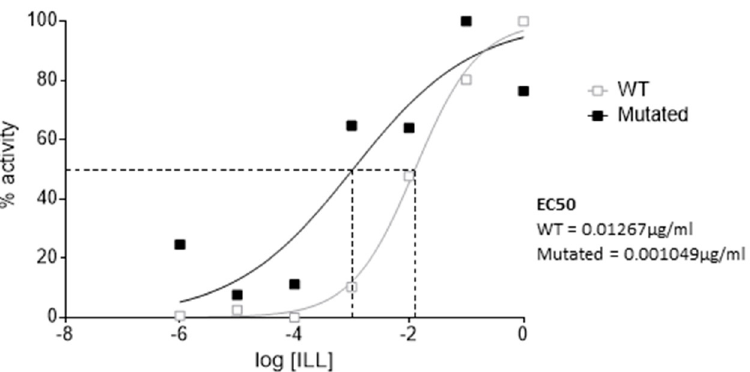
Figure 2. The mutated hPAP42mer peptide increases the immunogenicity of the vaccine against several class-I and class-II PAP-derived epitopes and increases the functional avidity towards the ILL HLA-A*0201 epitope. HHDII/DR1 mice were immunized on days 1, 15, and 29 with either hPAP 42 mer WT or mutated peptide with CpG adjuvant. Seven days after the last immunization, splenocytes were isolated from spleens and an in vitro IFN γ ELISpot assay was performed. Splenocytes were stimulated with ( A ) hPAP-derived class I and class II peptides or ( B ) decreasing concentrations of ILL 9 mer peptide, for 48 h at 37 °C. Immunization with the mutated hPAP42mer peptide induced higher numbers of peptide-specific IFN γ -releasing T cells and induced T cells with a higher functional avidity for ILL 9 mer peptide than immunization with the WT hPAP42mer peptide. Bars represent the mean number of spots, and the error bars represent the SD. Sigmoidal curve representing the functional avidity of ILL 9 mer peptide ( B , bottom). Two independent experiments performed ( n = 6–7 mice per test group). A significant difference in the induction of peptide-specific IFN γ -releasing T cells between immunization groups was determined using a two-way ANOVA comparison test. The p -values were annotated as follows: * p < 0.05, ** p < 0.01, *** p <